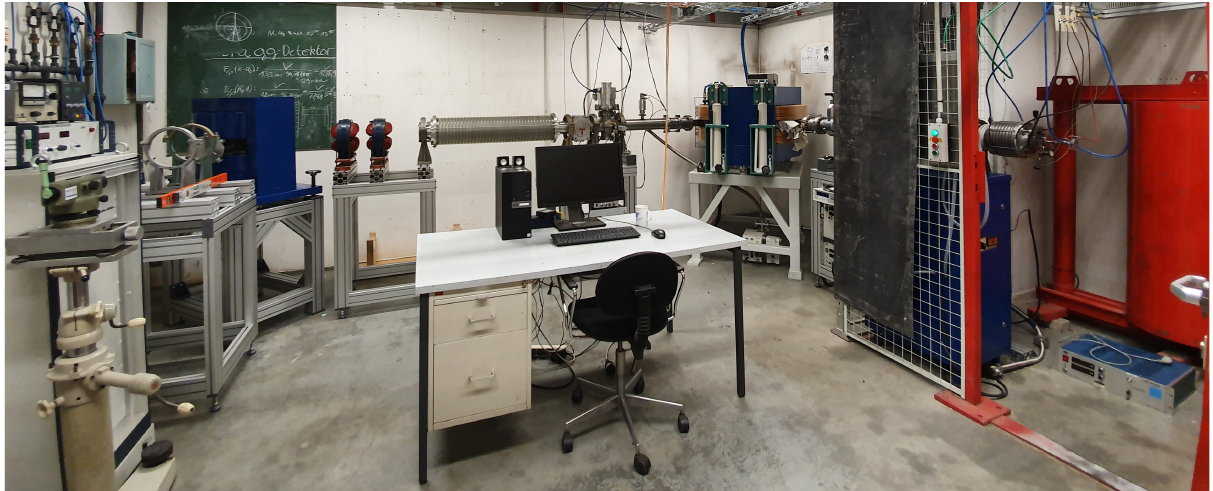
Figure 2. The new 100 kV Tandem accelerator. Shown is (from right to left): the ion source, the double focusing 90 ◦ analyzing magnet, ρ = 500 mm, the 1 m acceleration tube (without grounded protection housing), the quadrupole doublet and the 90 ◦ analyzing magnet, ρ = 190 mm. Beam line components between accelerator and second magnet had not been